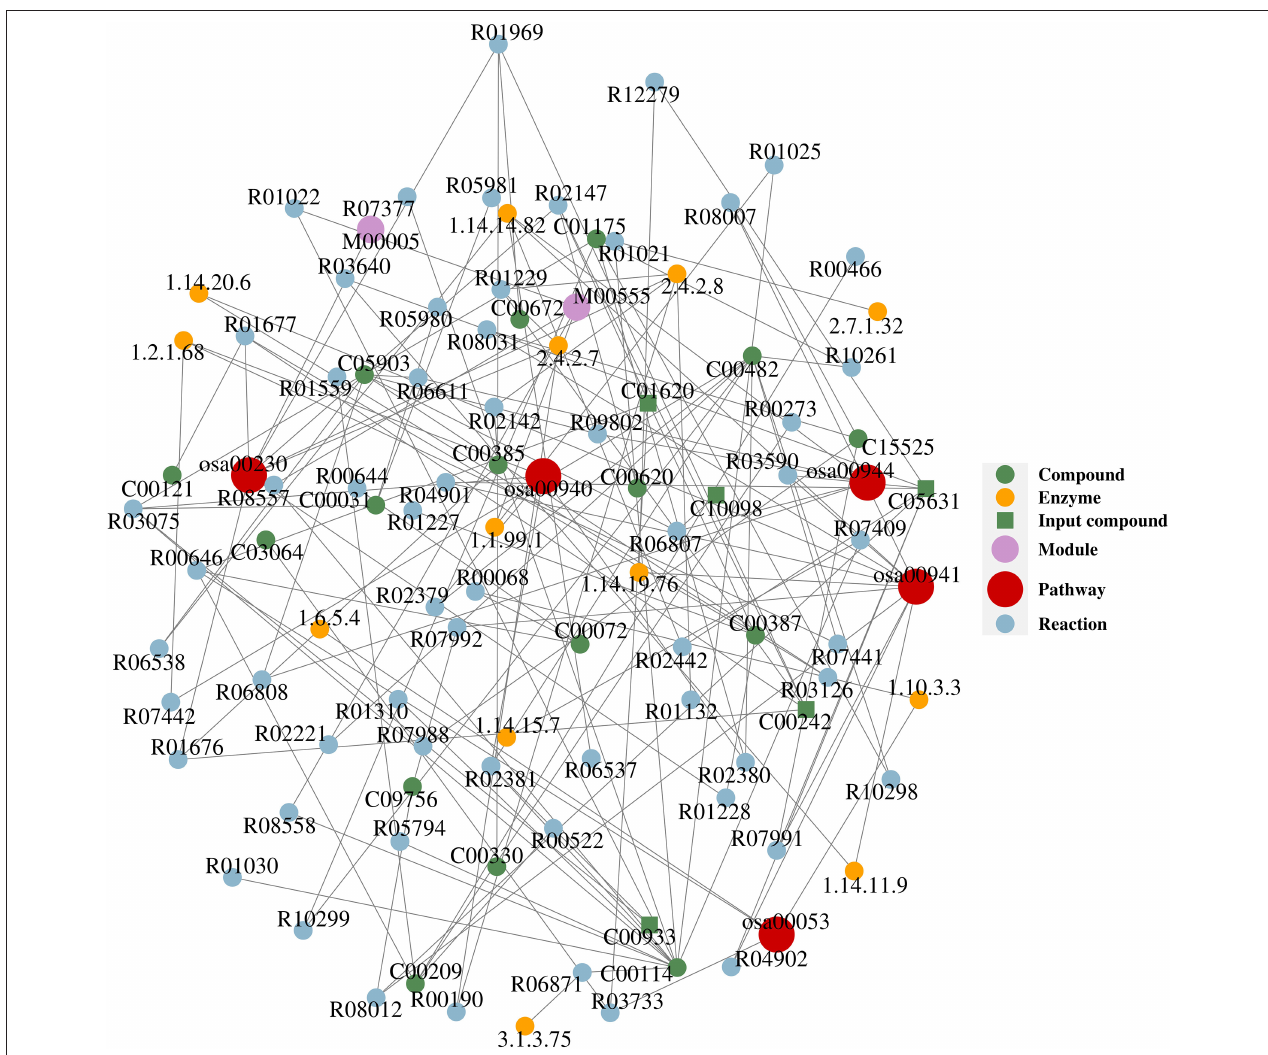
FIGURE 2 | The compound–reaction–enzyme–pathway networks of the targeted metabolites. Compounds: C00031 (D-glucose), C00072 (ascorbate), C00114 (choline), C00121 (D-ribose), C00209 (oxalate), C00242 (guanine), C00330 (deoxyguanosine), C00385 (xanthine), C00387 (guanosine), C00482 (sinapate), C00620 (alpha-D-ribose 1-phosphate), C00672 (2-deoxy-D-ribose 1-phosphate), C00933 (sinapine), C01175 (1-O-sinapoyl-beta-D-glucose), C01620 (threonate), C03064 (3-dehydro-L-threonate), C05631 (eriodictyol), C05903 (kaempferol), C09756 (homoeriodictyol), C10098 (kaempferide), C15525 (eriodictyol chalcone). Reactions: R00068 (L-ascorbate:oxygen oxidoreductase), R00190 (AMP:diphosphate phospho-D-ribosyltransferase), R00273 (oxalate:oxygen oxidoreductase), R00466 (glyoxylate:oxygen oxidoreductase), R00522 (oxalate carboxy-lyase), R00644 (L-ascorbate:hydrogen-peroxide oxidoreductase), R00646 (ascorbate + oxygen + H 2 O < = > threonate + oxalate), R01021 (ATP:choline phosphotransferase), R01022 (choline:oxygen 1-oxidoreductase), R01025 (choline:acceptor 1-oxidoreductase), R01132 (IMP:diphosphate phospho-D-ribosyltransferase), R01227 (guanosine 5 ′ -monophosphate phosphohydrolase), R01228 (ATP:guanosine 5 ′ -phosphotransferase), R01229 (GMP:diphosphate 5-phospho-alpha-D-ribosyltransferase), R01310 (phosphatidylcholine phosphatidohydrolase), R01559 (succinyl-CoA:oxalate CoA-transferase), R01676 (guanine aminohydrolase), R01677 (guanosine ribohydrolase), R01969 (deoxyguanosine:orthophosphate ribosyltransferase), R02142 (XMP:pyrophosphate phosphoribosyltransferase), R02147 (guanosine:phosphate alpha-D-ribosyltransferase), R02221 [sinapate:CoA ligase (AMP-forming)], R02379 (S-adenosyl-L-methionine:3,4-dihydroxy-trans-caffeoyl-coenzyme), R02380 (UDPglucose:sinapate D-glucosyltransferase), R02381 (sinapoylcholine sinapohydrolase), R02442 (naringenin,[reduced NADPH—hemoprotein reductase), R03075 (1-O-(4-hydroxy-3,5-dimethoxycinnamoyl)-beta- dimethoxycinnamoyl), R03126 (dihydroflavonol,2-oxoglutarate:oxygen oxidoreductase), R03590 (flavanone,2-oxoglutarate:oxygen oxidoreductase), R03640 (flavanone,2-oxoglutarate:oxygen oxidoreductase), R03733 (L-threonate:NAD + 3-oxidoreductase), R04901 ((2S)-flavan-4-ol:NADP + 4-oxidoreductase), R04902 (eriodictyol,[reduced NADPH—hemoprotein reductase), R05794 (CDP-diacylglycerol:choline O-phosphatidyltransferase), R05980 (Glc2Man9GlcNAc2-[protein] 3-alpha-glucohydrolase), R05981 (GlcMan9GlcNAc2-[protein] 3-alpha-glucohydrolase), R06537 (apigenin,[reduced NADPH—hemoprotein reductase), R06538 (kaempferol,[reduced NADPH—hemoprotein reductase), R06611 (UDPglucose:flavonol 3-O-D-glucosyltransferase), R06807 (S-adenosyl-L-methionine:kaempferol 4’-O-methyltransferase), R06808 (UDP-alpha-D-galactose:kaempferol 3-O-beta-D-galactose), R06871 (phosphocholine phosphohydrolase), R07377 (phosphatidylcholine + L-Serine < = > phosphatidylcholine), R07409 (choline,reduced-ferredoxin:oxygen oxidoreductase), R07441 (sinapoyl aldehyde:NAD oxidoreductase), R07442 (sinapoyl aldehyde:NAD oxidoreductase), R07988 (malonyl-CoA:caffeoyl-CoA malonyltransferase), R07991 (eriodictyol chalcone < = >